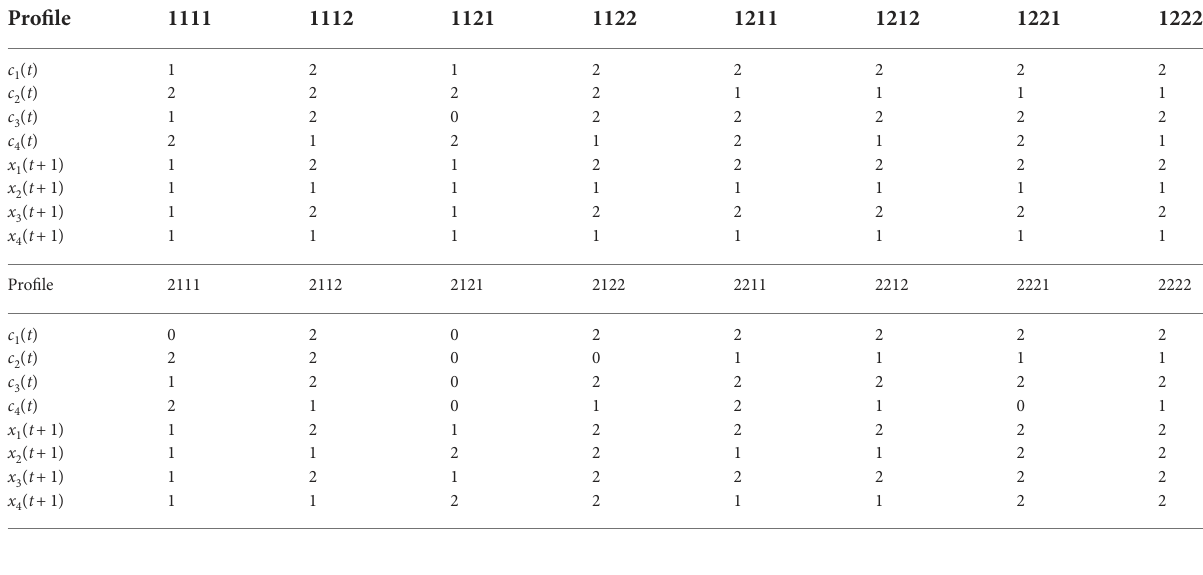
TABLE 3 StrategyupdatingforthecaseoftwoGPOsandtwoGPPs.